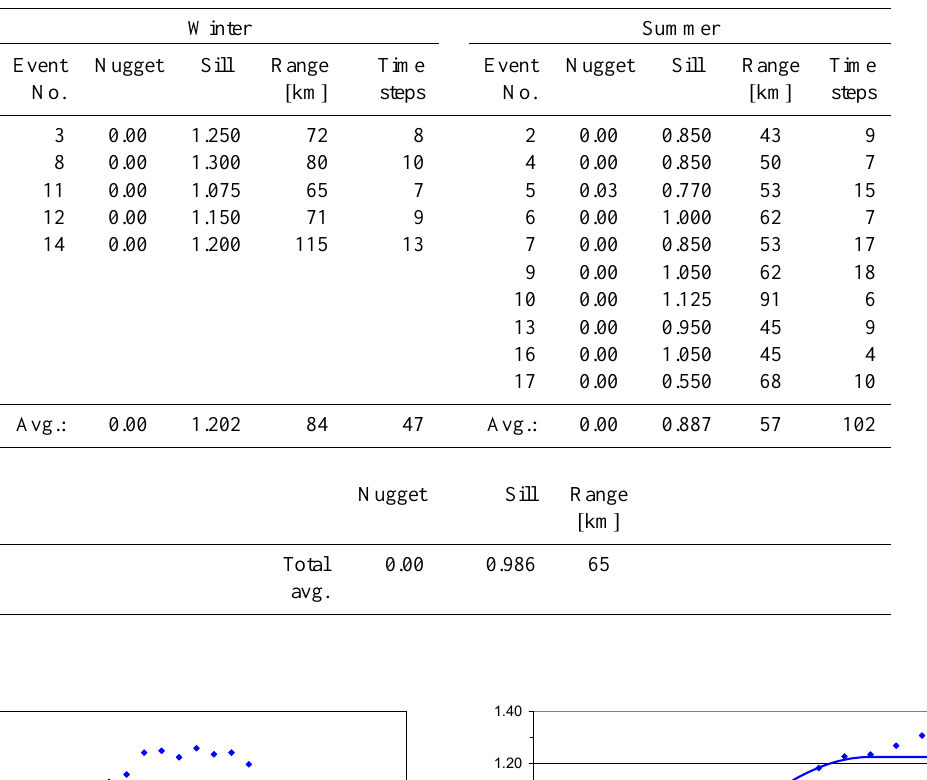
Table 3. Estimated semivariogram parameters considering a spherical model for each event, averaged over seasons and averaged over all events (sill is standardised with variance; only time steps with radar rainfall intensity > 1mmh − 1 are used for variogram estimation).